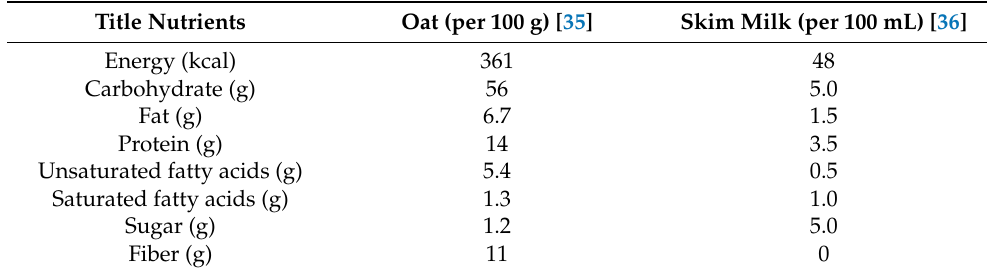
Figure 3. Changes of the blood glucose level in mmol/L (mean ± SD) from pre-meal to 15 post- HIIT in the two groups (* p < 0.05; significant differences between the oatmeal group and control group were detected by an independent t -test).